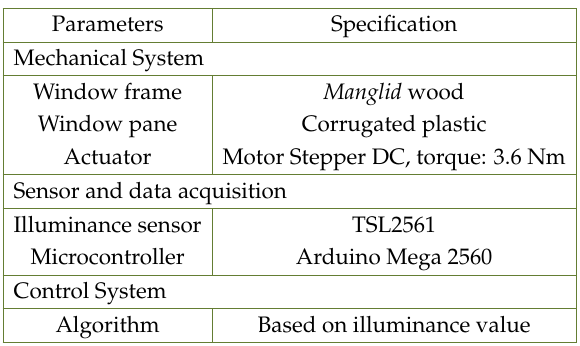
Table 1. Specifications of automated shading